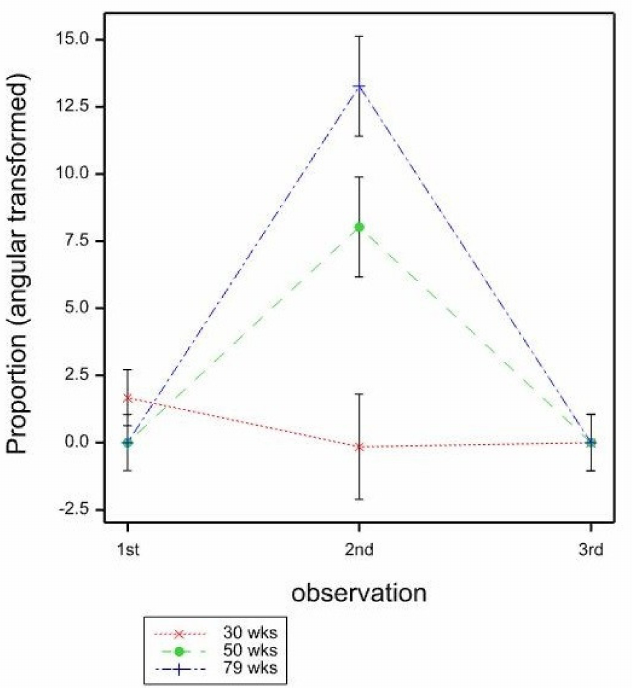
Figure 5. Mean proportions (angular transformed) of hens foraging on the mats by age (30, 50, 79 weeks) and observation (1st, 2nd, 3rd) estimated from LMM. Mean SE 1.808. Statistical results for other behaviours are not reported, due to their rare